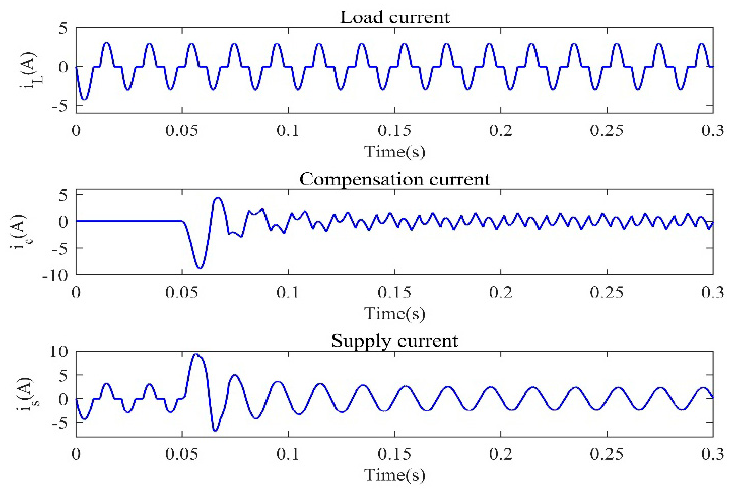
Figure 5. Current waveforms of steady − state response using ASMC-NFNN from top to bottom: load, compensation, and source currents.